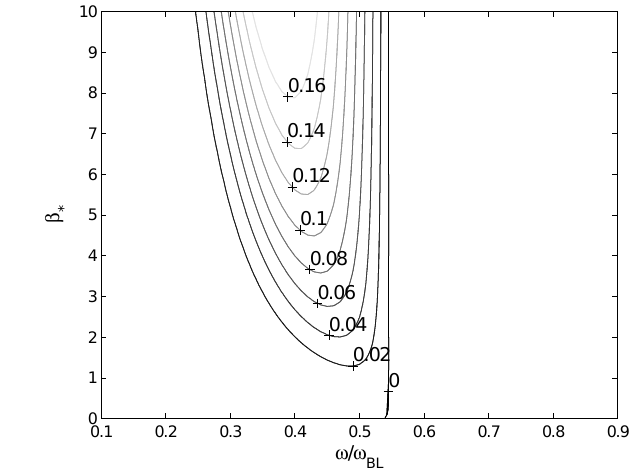
Figure 2. Dependence of the relative total amplification (cid:48)/A on the relative frequency ω/ω BL and the energy of particles, characterized by the parameter β ∗ , with q = 1 .